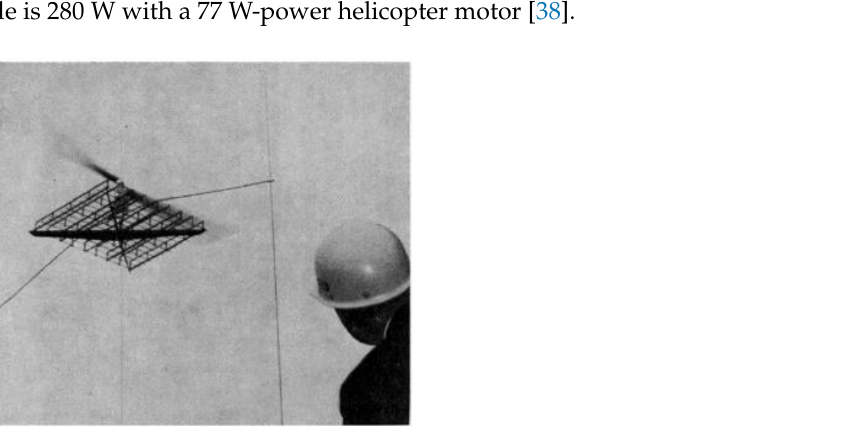
Figure 9. Experiment of Raytheon. Reproduced with permission from Ref. [38]; published by IEEE, 1965.